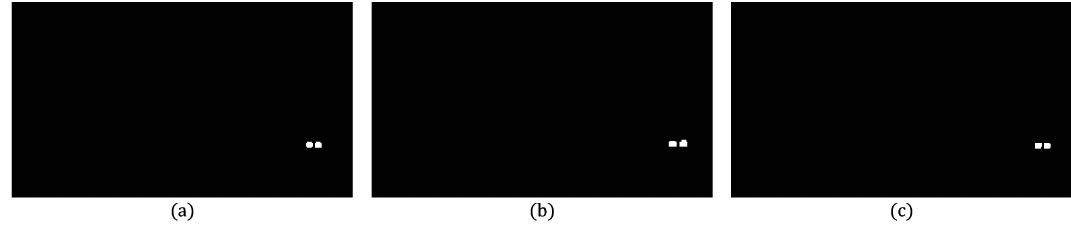
Figure 9. Mask image to calculate the ROC and